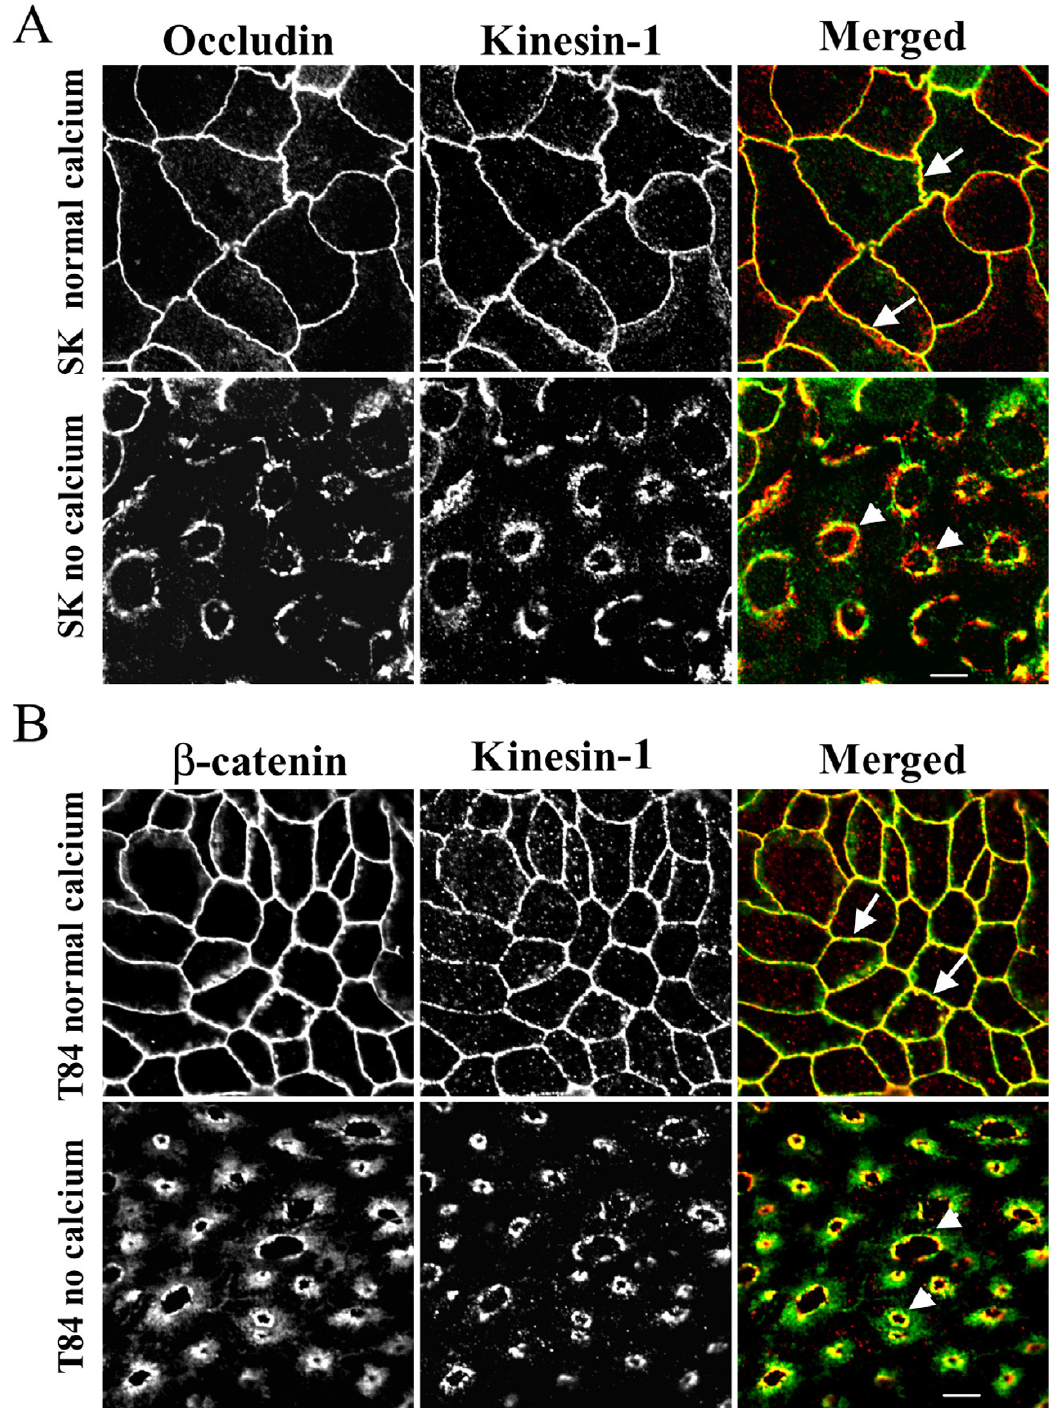
Figure 7 Kinesin-1 is localized at intact and internalized apical junctions in colonic epithelial cells. In confluent SK-CO-15 (A) and T84 (B) epithelial cell monolayers cultured at high-calcium conditions, kinesin-1 (red color) colocalizes with the TJ pro- tein occludin and the AJ protein β -catenin (arrows). In calcium-depleted cells, kinesin-1 colocalizes with internalized junctional proteins (arrowheads). Bar, 5 µ